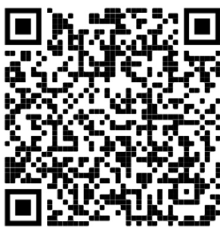
Figure 5. QR code for accessing the questionnaire about the visit to the Museum of